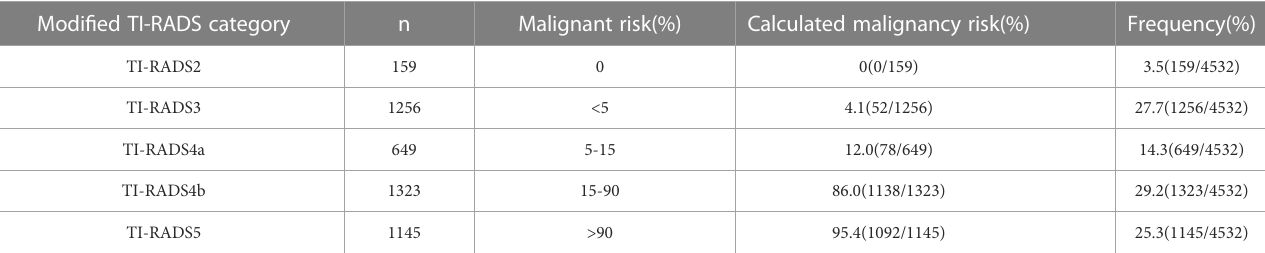
TABLE 3 Malignancy risk according to category in the modi fi ed version of the TI-RADS. Modi fi ed TI-RADS